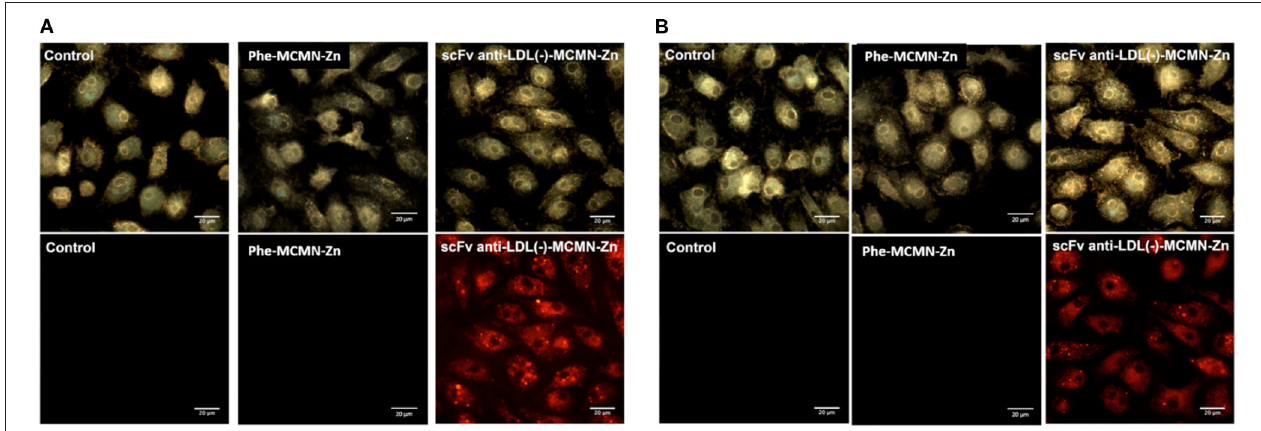
FIGURE 2 | Internalization of the scFv-anti-LDL(-)-MCMN-Zn nanoformulation, by human and murine primary macrophages, monitored by enhanced dark-field microscopy (upper images; CytoViva ® ) and fluorescence (lower images; red emission). Data from (A) human and (B) murine macrophages treated 3h with 10 4